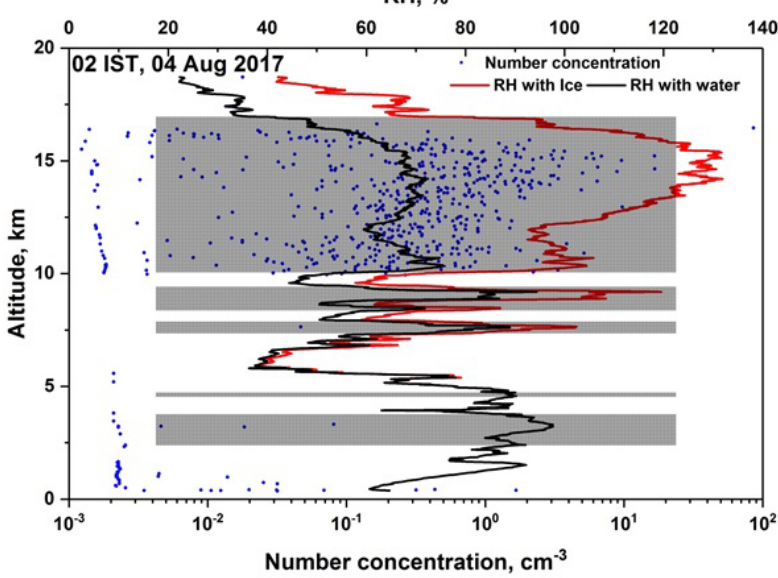
Figure 2. Results from a flight of RS-11G radiosonde and cloud particle sensor (CPS) sonde on the same balloon launched at 02:00IST on 4 August 2017 at Gadanki, India. Profiles of RH estimated with respect to water (solid black line), ice (when temperatures are less than 0 ◦ C, solid red line), and number concentration (filled blue circles) from CPS sonde profile are shown. Detected cloud-layer boundaries are shown by the filled gray rectangular boxes. The increase in the number concentration within the detected cloud layers indicates that the cloud-layer boundaries detected in the present study are